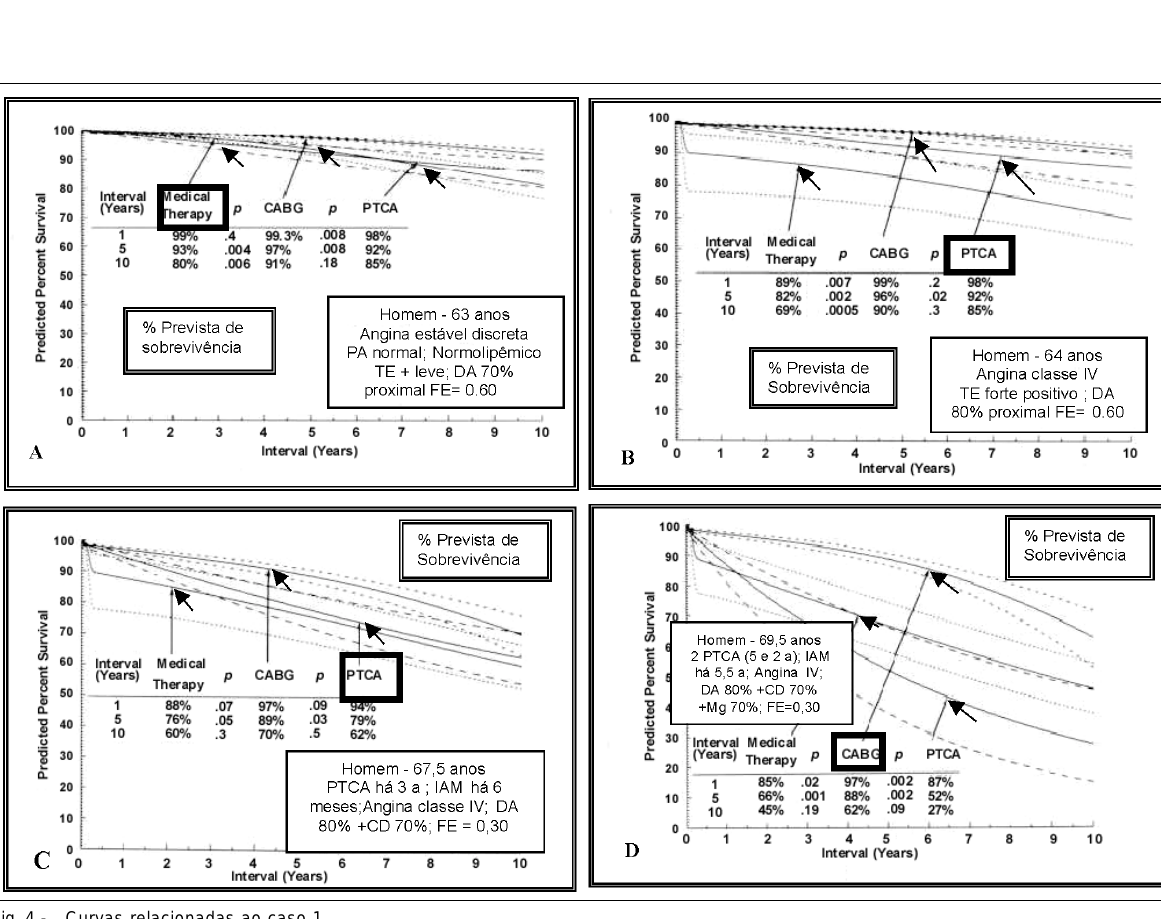
Fig. 4 - Curvas relacionadas ao caso 1. (Fonte: Kirklin J W & Barrat-Boyes B G. Cardiac surgery. 2.ed. New York: Churchill Livingstone, 1993.